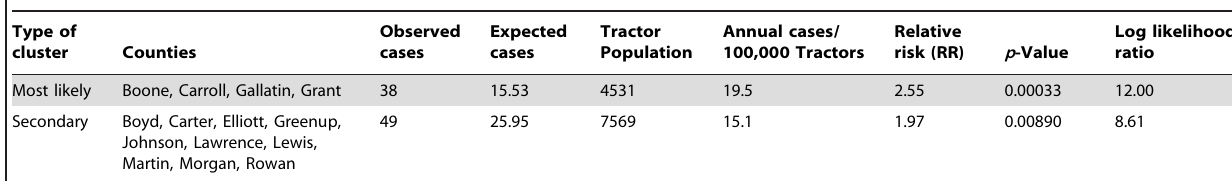
Table 1. Purely spatial high-risk clusters of tractor overturns in Kentucky, 1960–2002.